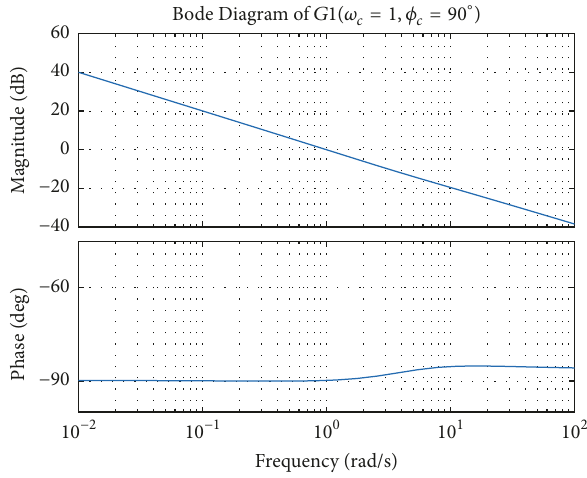
Figure 10: Bode diagram of 𝑃 1 (𝑠) .